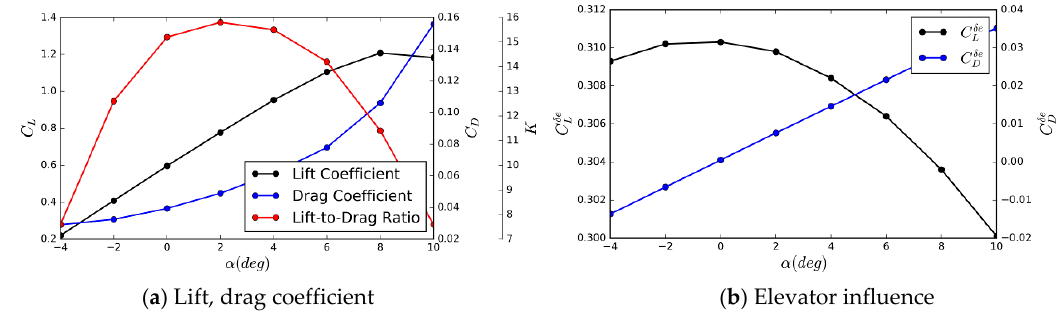
Figure 22. Longitudinal aerodynamic coefficient.